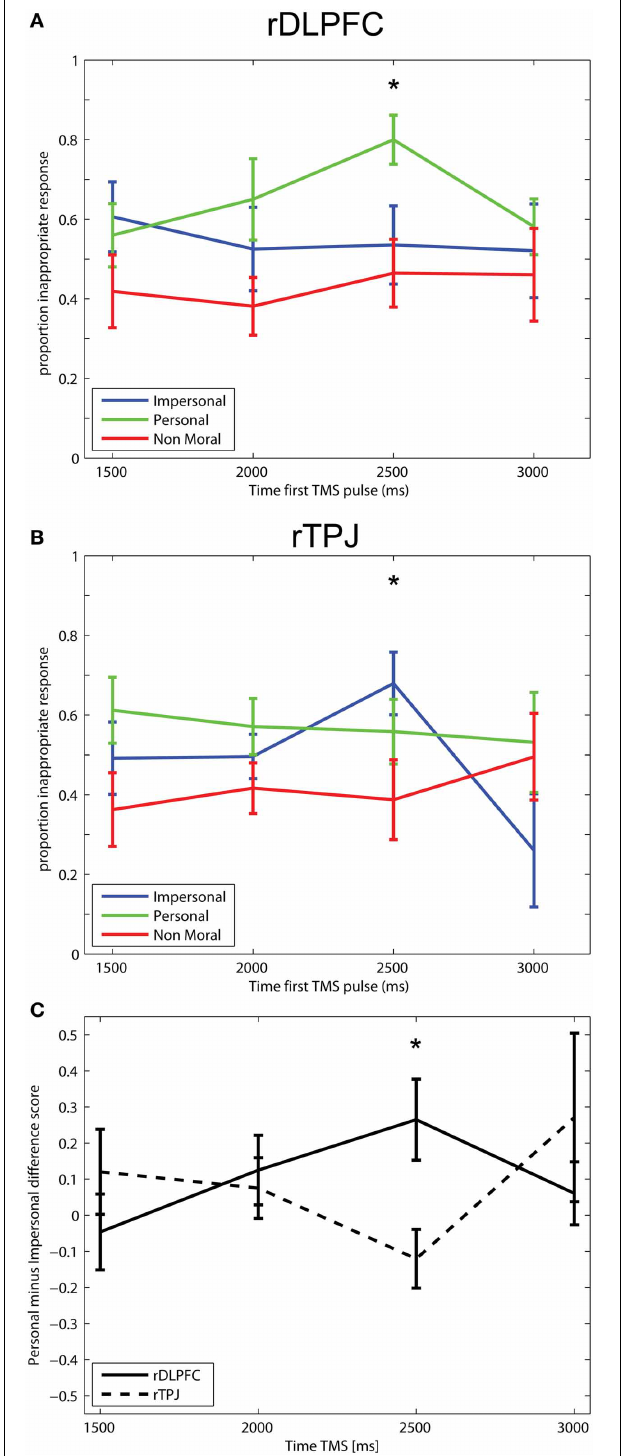
FIGURE 3 | Responses in TMS experiment. Proportion inappropriate responses in the three different moral conditions for the four different time points of TMS application. Error bars indicate one standard error from the